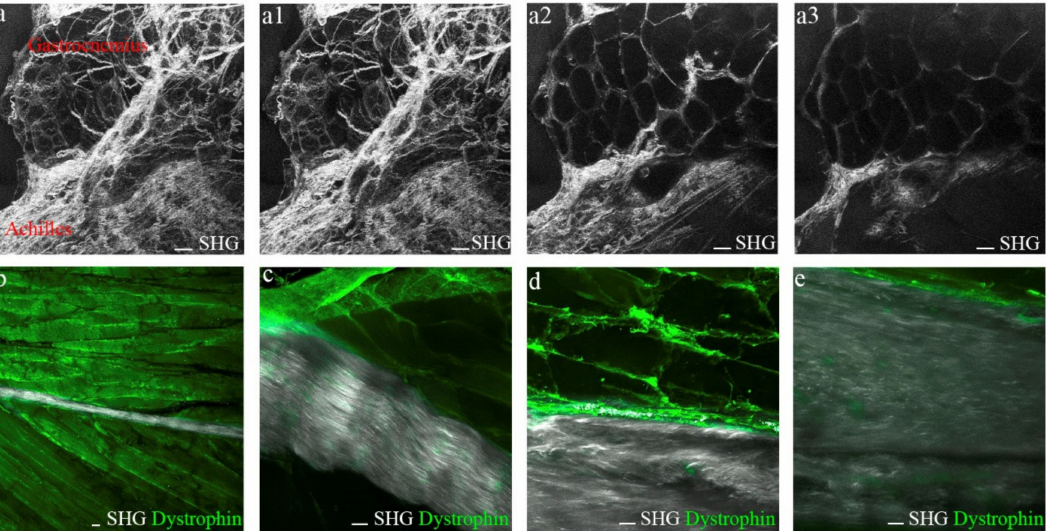
Figure 5. SHG signals from collagen fibers of muscle and tendon origin. ( a – a3 ) Representative multiphoton images of the Achilles tendon-gastrocnemius unit from healthy mice. ( a ) Maximal Z-stack projection image and ( a1 – 3 ) representative images from different Zs. Scale bar 100 µ m. Representative SHG collagen signals combined with dystrophin immunostaining of ( b , c ) healthy and ( d , e ) injured Achilles tendons. Scale bar 20 µ m. SHG, second-harmonic